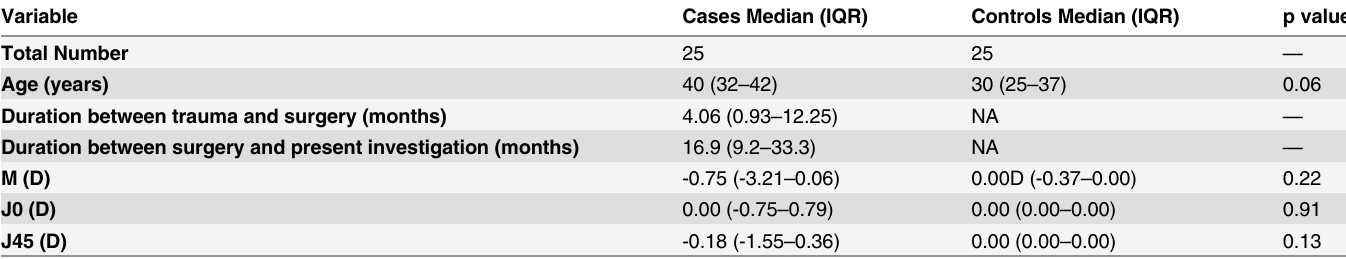
Table 1. Demographic details of the cases and controls who participated in this